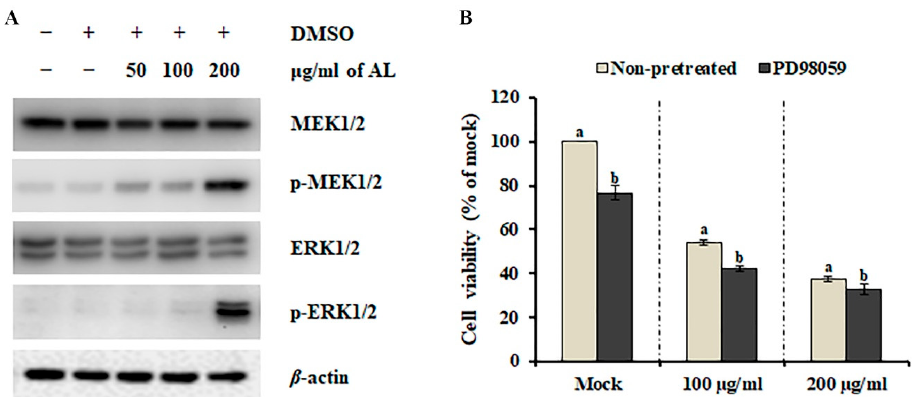
Figure 4. Effect of the MEK/ERK signaling pathway on Abeliophyllum distichum leaves extract (AL)-induced cell death. ( A ) The protein and activation levels of MEK1/2 and ERK1/2 were analyzed using western blotting after AL treatment. ( B ) Cell viability of SK-MEL-2 cells co-treated with AL and PD98059 for 48 h was assessed using MTT assay. Values in the same column with different superscript letters are significantly different ( p < 0.05).